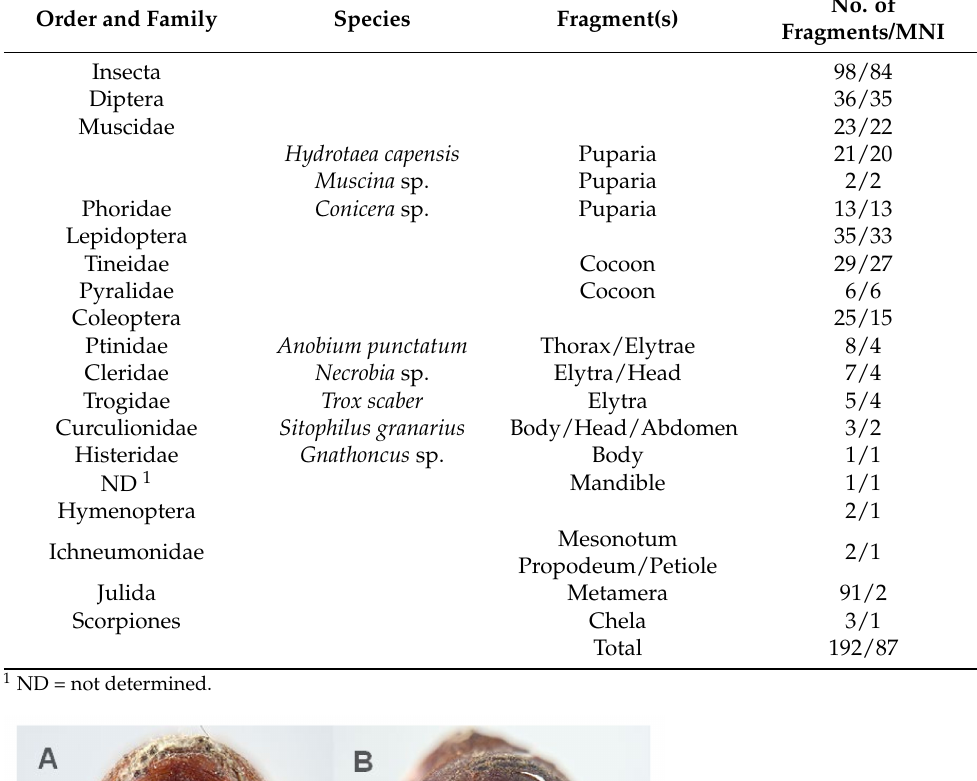
Table 1. Number of fragments and minimum number of individuals (MNI) per taxon.